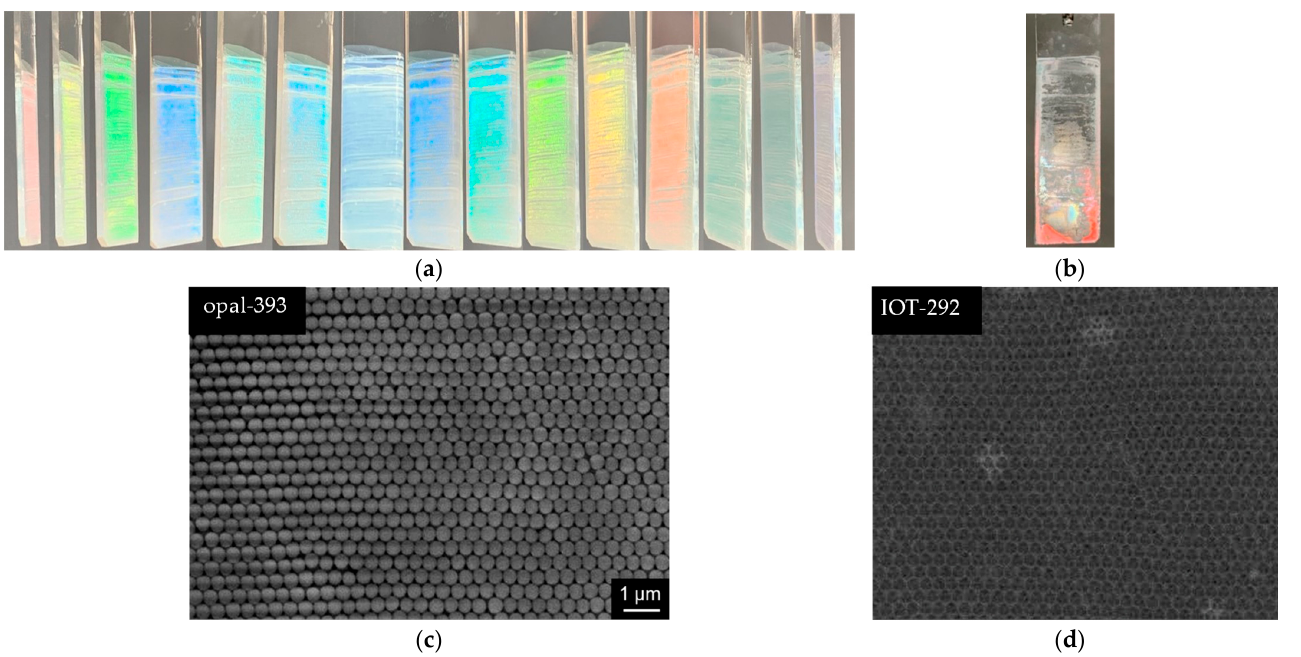
Figure 2. ( a ) The color changes of silica opal film (opal-393) with different observation angle and ( b ) corresponding IOT (IOT-292); ( c ) SEM image of opal with silica diameter of 393 nm and ( d ) corresponding IOT with pore diameter of 292 nm.